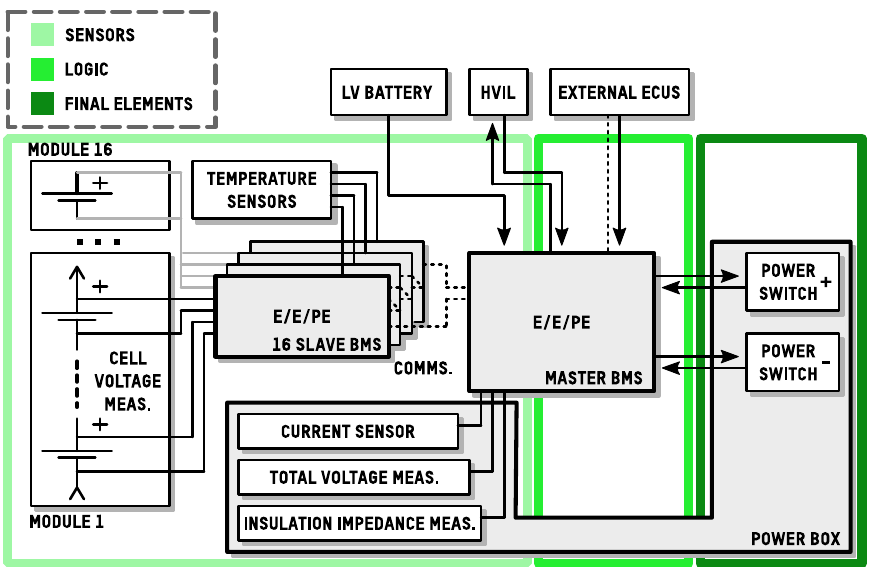
Figure 3. Technical safety architecture.